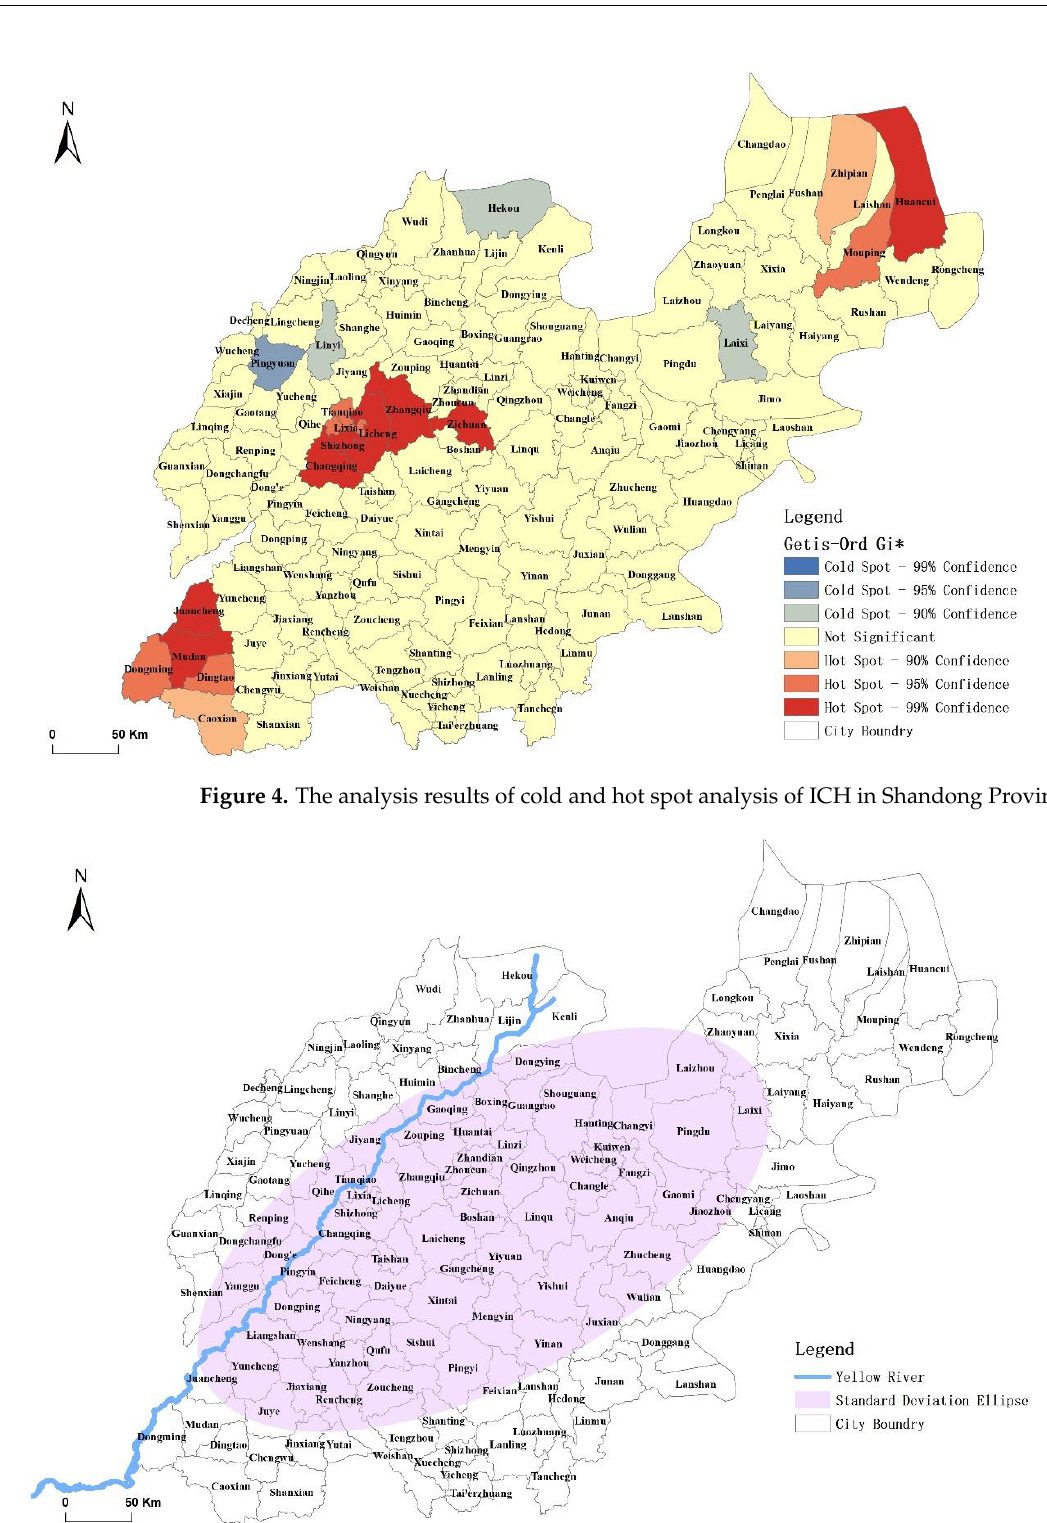
Figure 5. Spatial distribution map of ICH in Shandong Province .